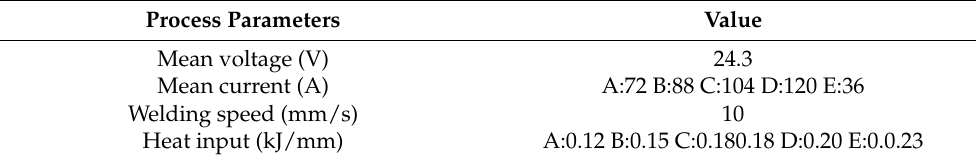
Table 2. Welding process parameters for pulsed gas metal arc welding